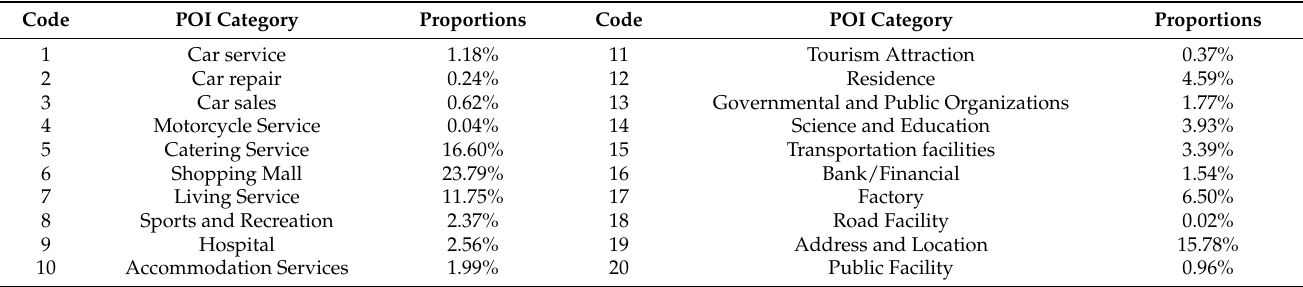
Table 1. The Proportions of primary categories in the study area.